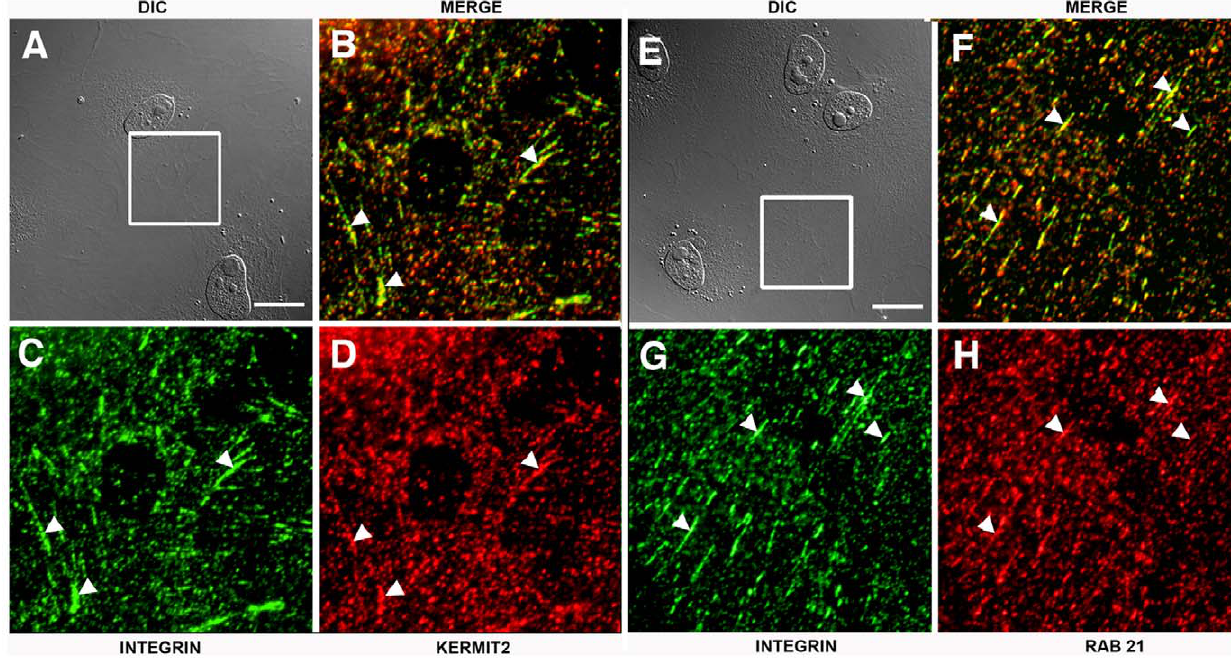
Figure 11. Colocalization of a 5 b 1, kermit2, and Rab 21 in Xenopus XTC cells. XTC cells were stained for a 5 b 1 (green), or kermit2 (red D), or Rab 21 (red H).(A,E) DIC images of adherentcells, boxesrepresentareas magnifiedin B–DandF–H. (A–D) Integrin (C; green) andkermit2 (D;red)colocalize in numerous vesicles and at focal adhesions (arrowheads in B–D). (E–H) Rab 21 (H; red) and integrin (G; green) colocalize in cytoplasmic vesicles and focal adhesions (arrowheads in F–H). Staining of cells with secondary antibodies alone produced no detectable signal. Size marker =25 m M.